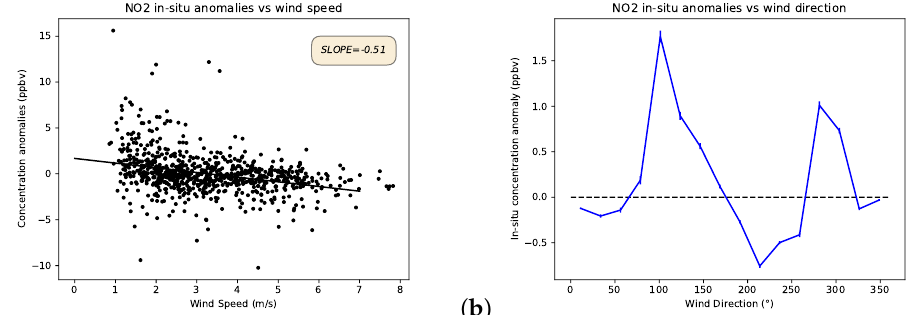
Figure 11. NO 2 in situ concentrations anomalies with respect to the wind speed ( a ) and wind direction ( b ) measured at 20